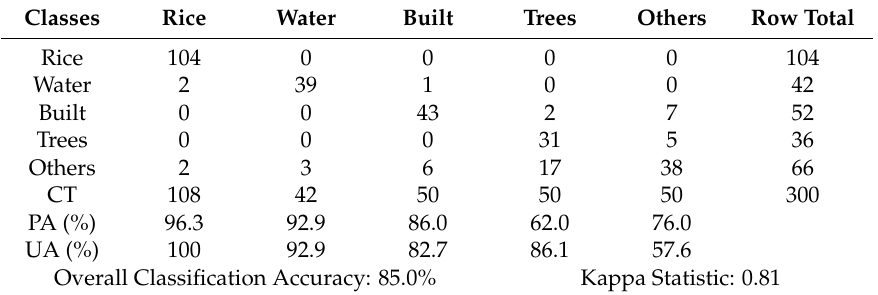
Table 6. Error matrix of accuracy assessment of classification with Sentinel-1A VH and Landsat 8 OLI. Classes Rice Water Built Trees Others Row Total Rice 104 0 0 0 0 104 Water 2 39 1 0 0 42 Built 0 0 43 2 7 52 Trees 0 0 0 31 5 36 Others 2 3 6 17 38 66 CT 108 42 50 50 50 300 PA (%) 96.3 92.9 86.0 62.0 76.0 UA (%) 100 92.9 82.7 86.1 57.6 Overall Classification Accuracy: 85.0% Kappa Statistic: